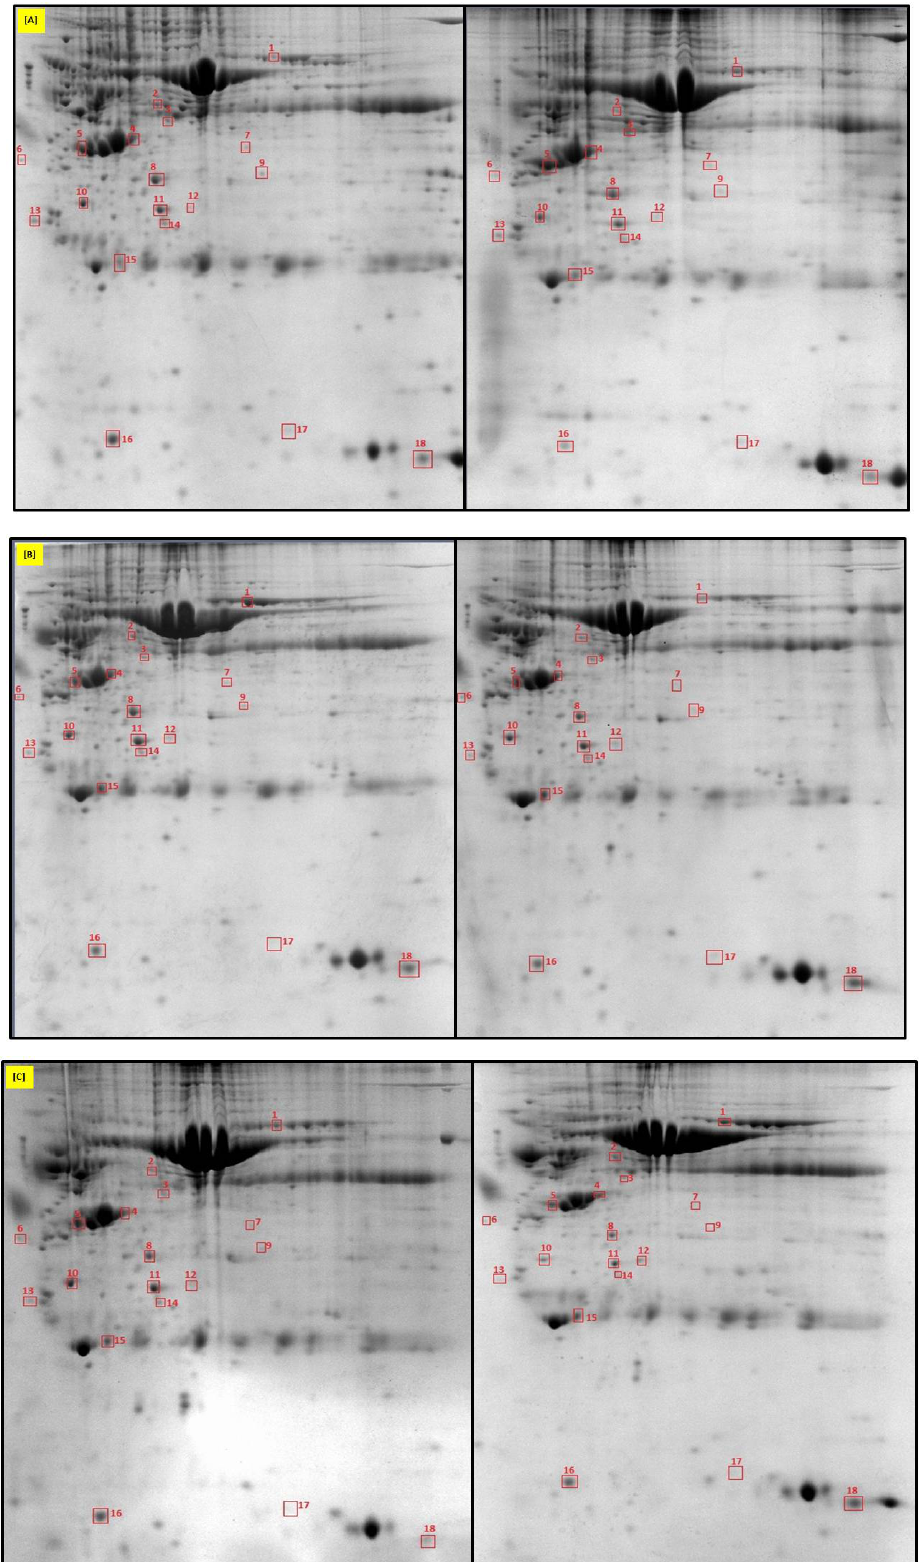
Figure 1. Identification of eighteen differntially expressed endometrial proteins at 9D ( A ), 12D ( B ), and 16D ( C ) of early pregnancy in Polish Large White gilts using two-dimensional IEF electrophoresis gels and MALDI TOF/TOF mass spectrometer.